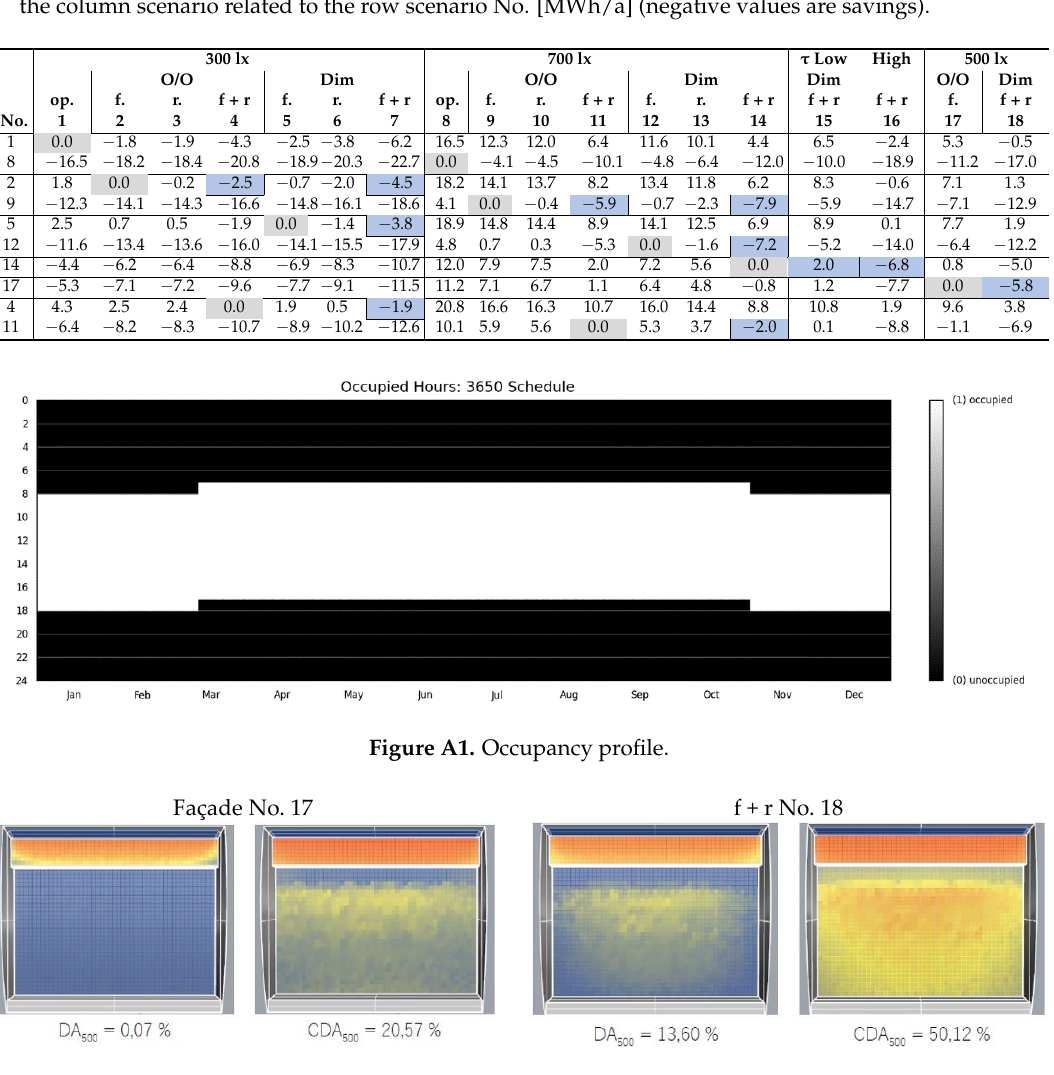
Table A4. Absolute electrical energy savings for AL in completive to Table 8: Absolute differences of the column scenario related to the row scenario No. [MWh/a] (negative values are savings).